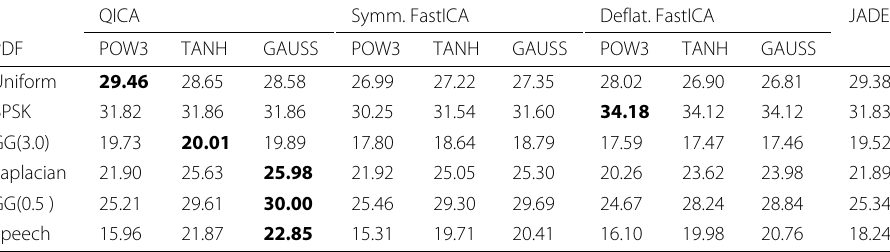
Table 2 Average SIR (dB) for 3 components with the same distribution excluding 1 Gaussian source, after k = 40